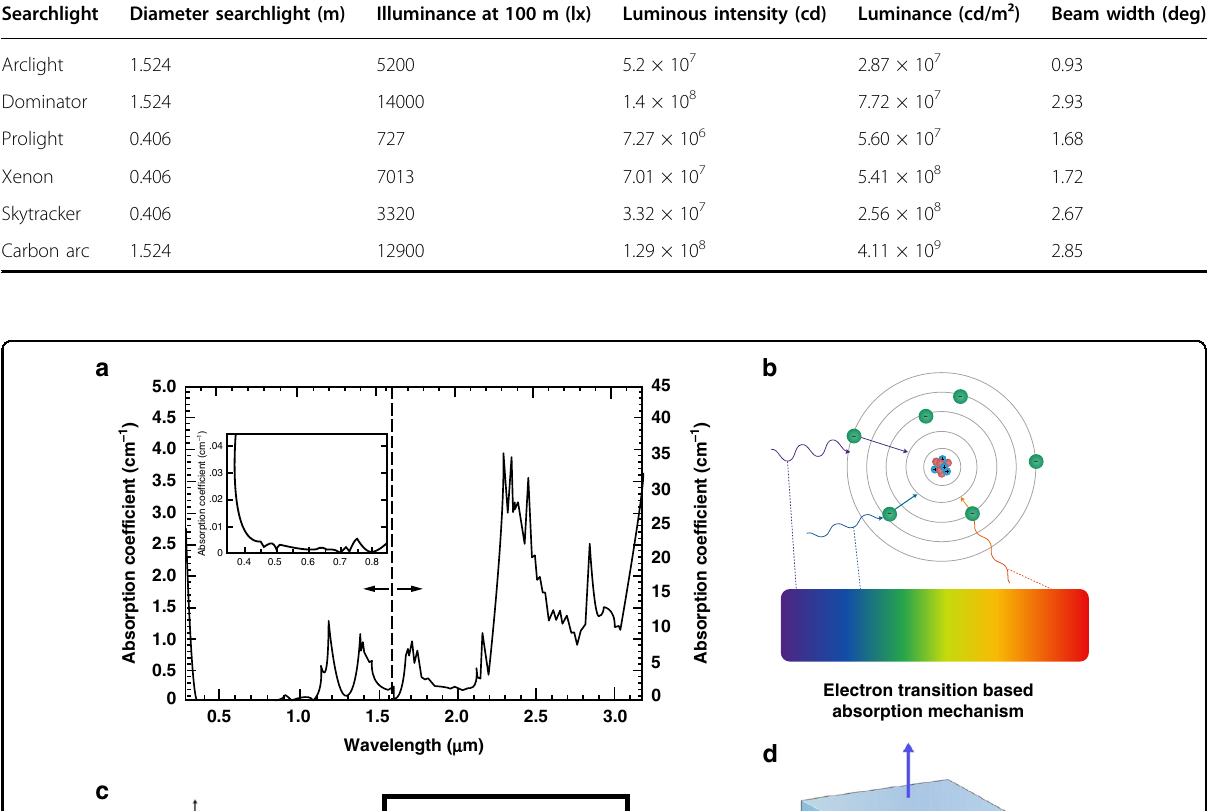
Searchlight Diameter searchlight (m)